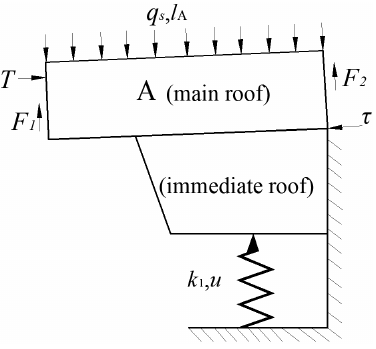
Figure 8. Simplified mechanical mode l .